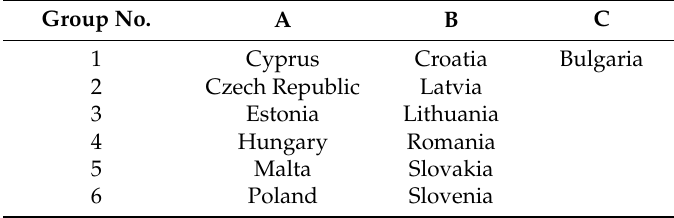
Table 7. Clusters for IRE in 2016.